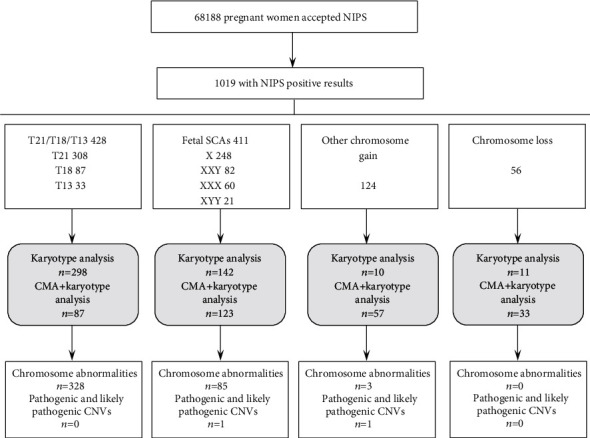
The general results of the present study.